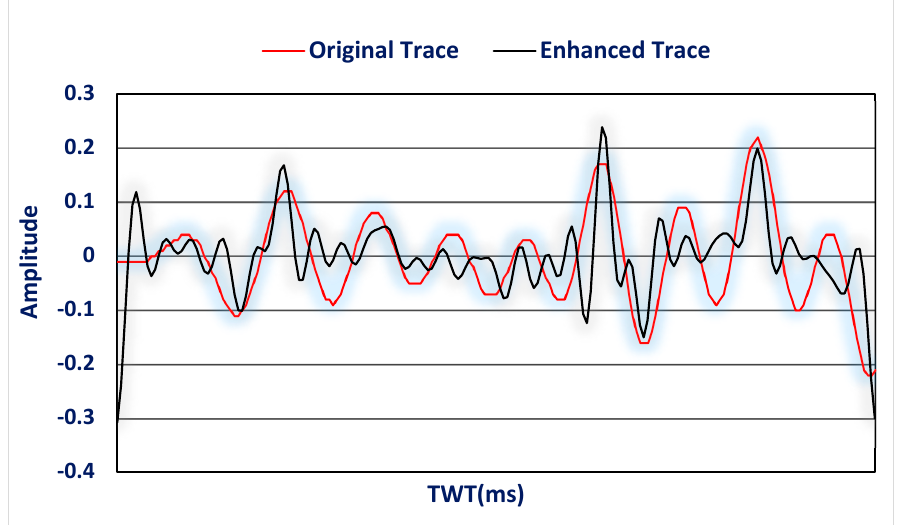
Figure 13. Comparison between the enhanced and original trace model. The time thickness resolution is sufficient, allowing very thin layers to be resolved within the modeled interval. The loop’s minimum resolvable time thickness fell from 11 ms to 2 ms. The bandwidth of the original seismic model was estimated to be around 68 Hz, as illustrated in Figure 14. Using the extrapolation methods described above, its band- width increased from 68 Hz to 161 Hz (Figure 10), a 137 (((161 − 68)/68) × 100) percent increase. Figure 14. ( a ) Data spectrum of the enhanced trace model ( b ) and spectrum of the original trace model The amplitude spectrum of the enhanced trace between 15 Hz and 68 Hz (bounded by the dashed red lines) mirrors that of the original normalized spectrum (Figure 14),